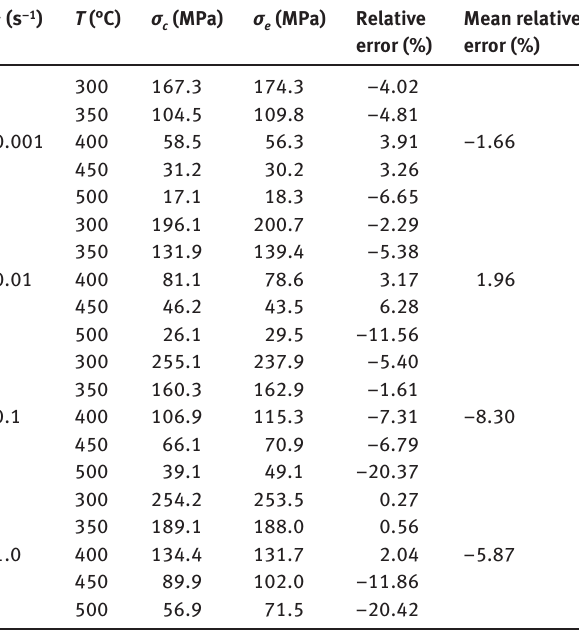
Table 2: Comparison between calculated and experimental